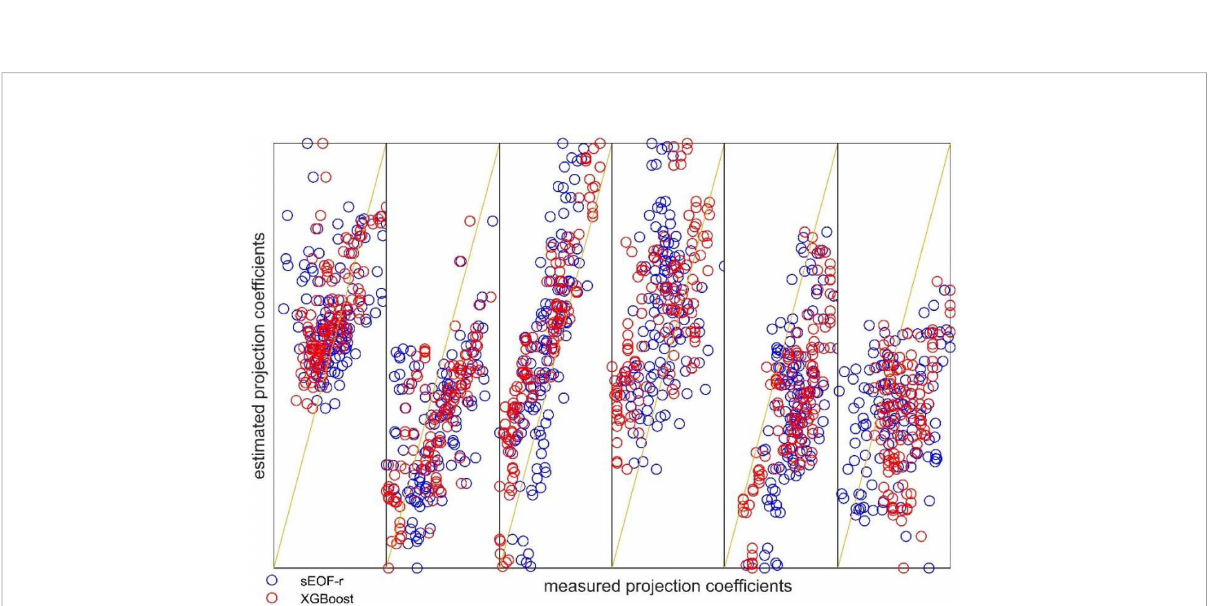
FIGURE 7 Results of the inversion of the normalized projection coef fi cients of the fi rst fi ve orders. The straight line indicates perfect inversion. The fi ve orders, from zero to the fi fth, are indicated from left to right.